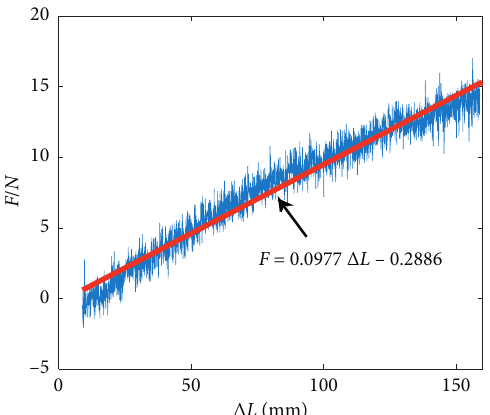
Figure 14: The force-deflection curve for a strip of the initial length of 410mm.